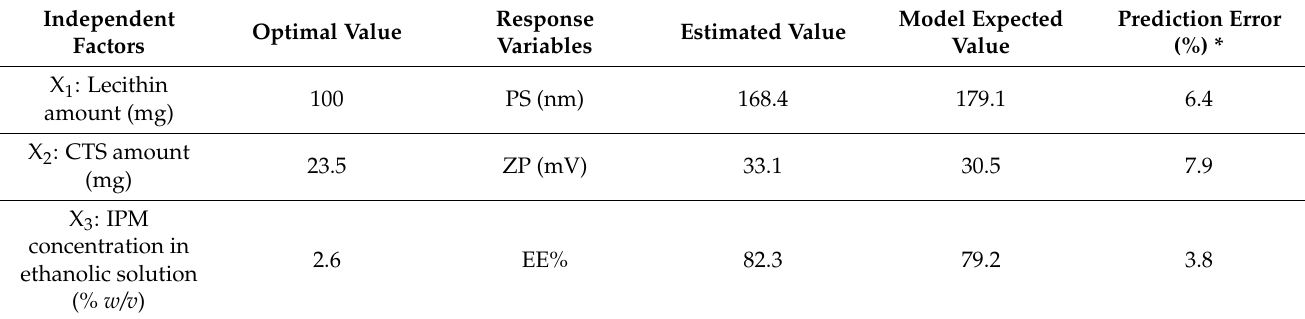
Table 3. Composition, experimental estimated value, and model expected value of the optimized BER-LC-CTS-NPs formulation.